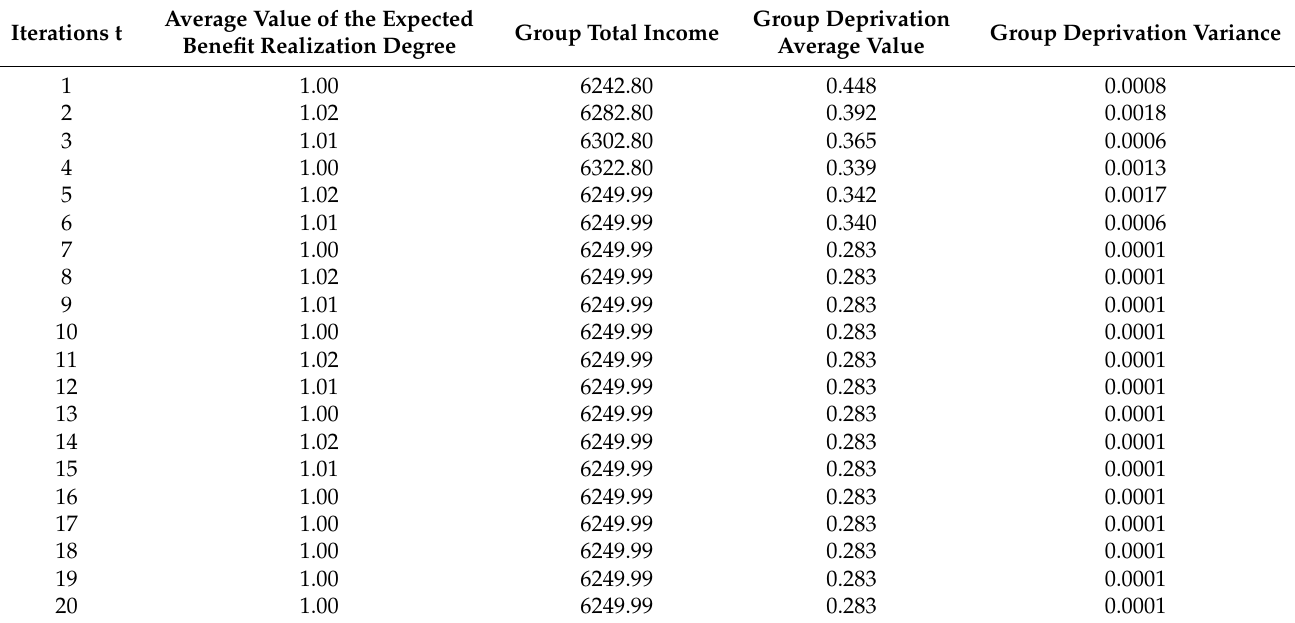
Table 6. Update of relevant indicators after adjustment of parameters.